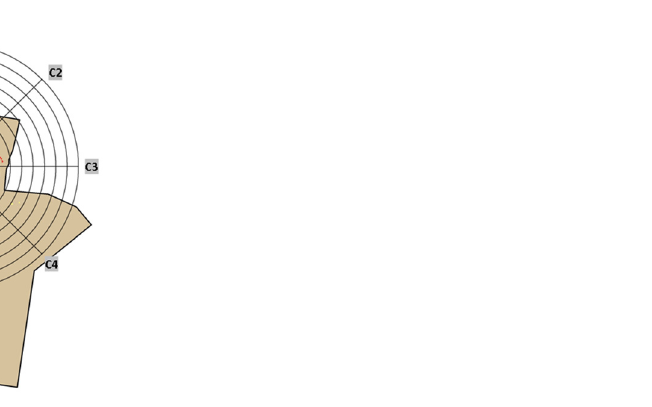
Figure 13. Land cover classification for the urban area of Smara (buffers shown every 360 m).